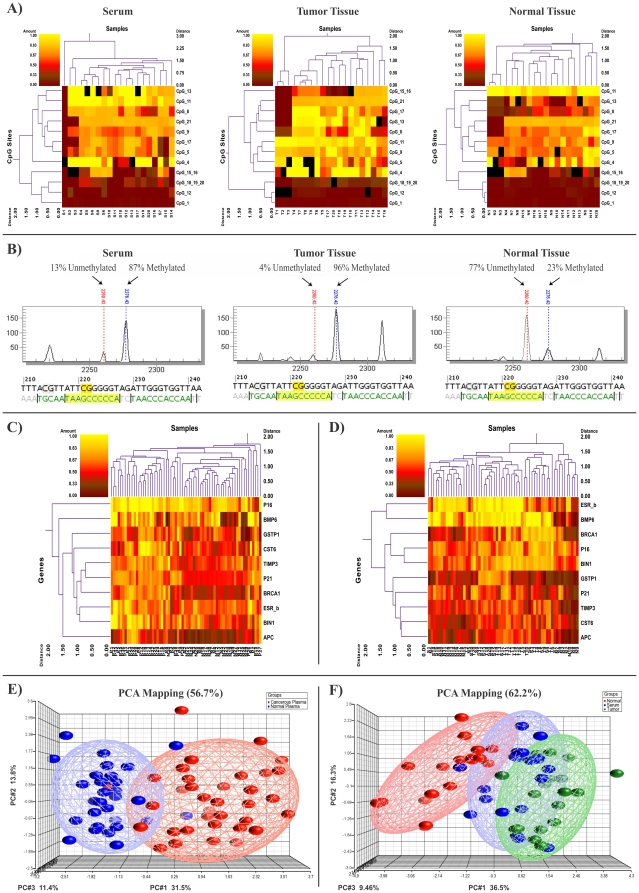
Methylation profiling of 10 candidate genes in two studied cohorts.A) An example of high-throughput methylation analysis of CpG sites for the BRCA1 gene for the 60 triple samples (cancerous tissue, matched normal tissue and serum samples). The complete data for the other genes is summarized in Dataset S1. B) Peaks show percentage of methylation extent obtained from an informative CpG site of BRCA1 gene with a significant difference between serum and tumor with normal tissue in a triple case. C) Double dendrogram profiles the mean methylation proportion of all 10 studied genes in plasma samples from breast cancer patients and normal subjects. D) Double dendrogram profiles the mean methylation proportion of all 10 studied genes in triple matched samples. E) PCA mapping of the mean methylation proportion of analyzed genes in plasma samples. F) PCA mapping of the mean methylation proportion of analyzed genes in triple matched samples.